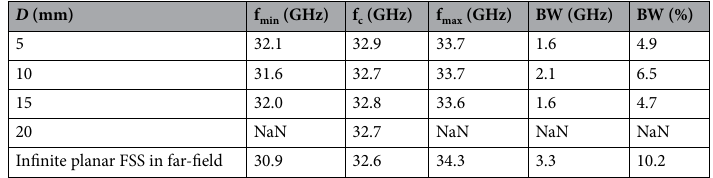
Table 2. Passband parameters of the planar